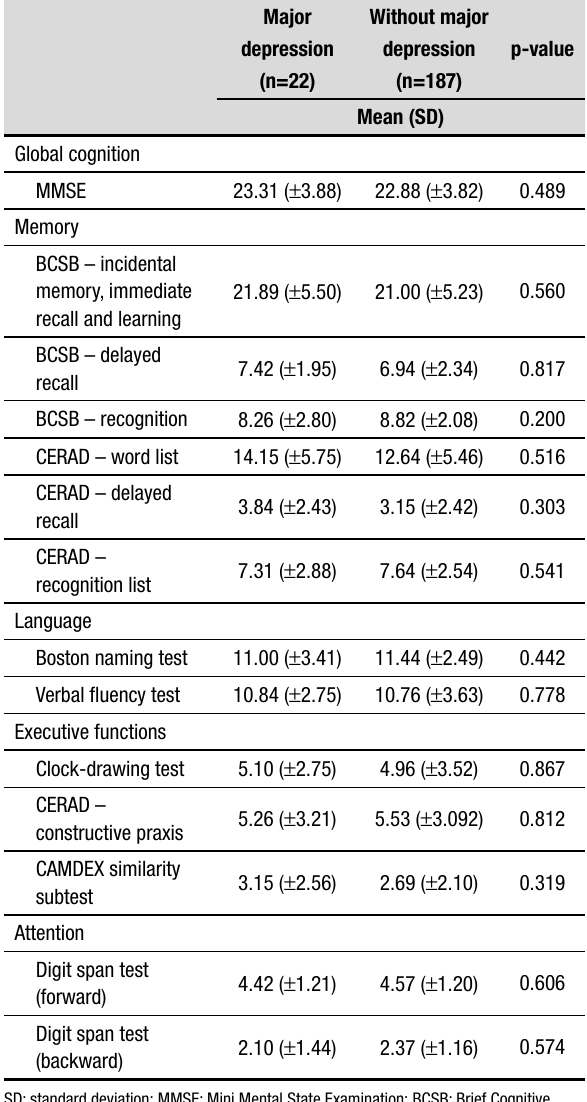
Table 2. Mean and standard deviation ( ± ) values according to the cognitive domains evaluated between groups with and without